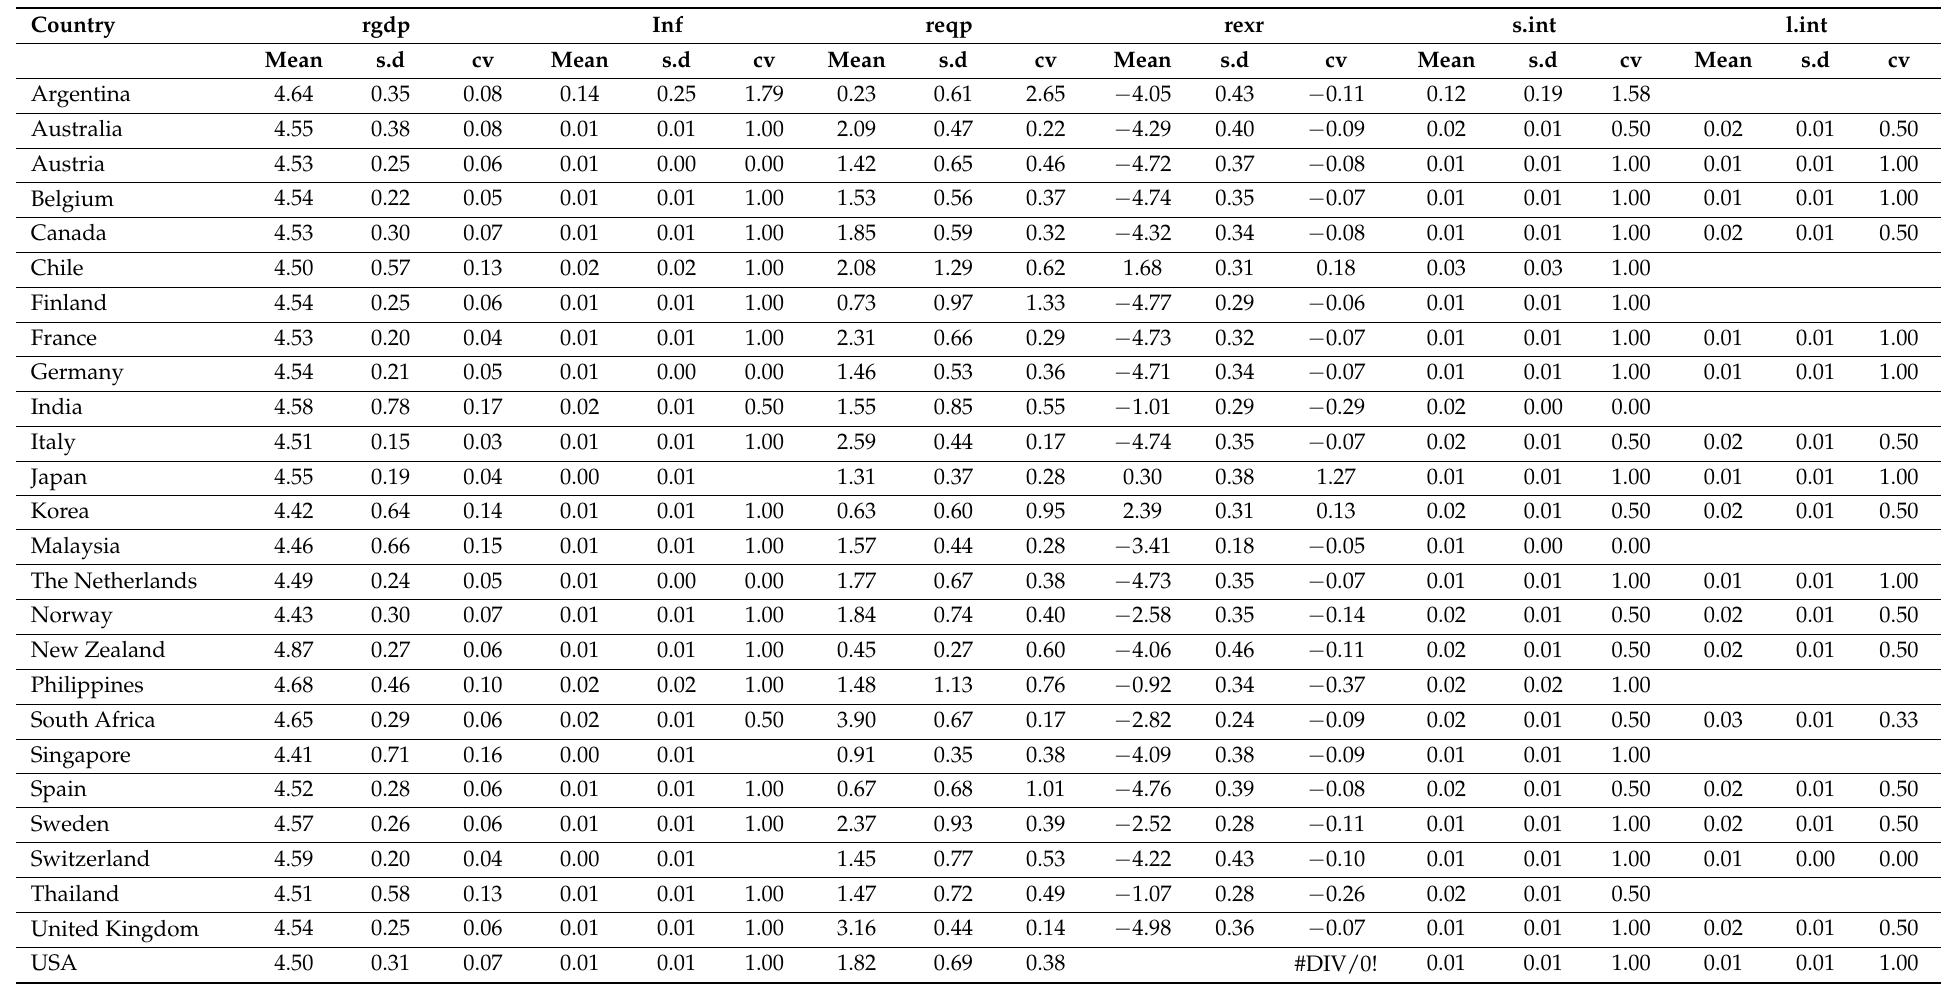
Table 1. Descriptive statistics of domestic